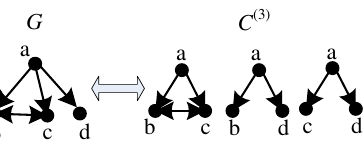
Figure 2. An example of G and C ( 3 ) .